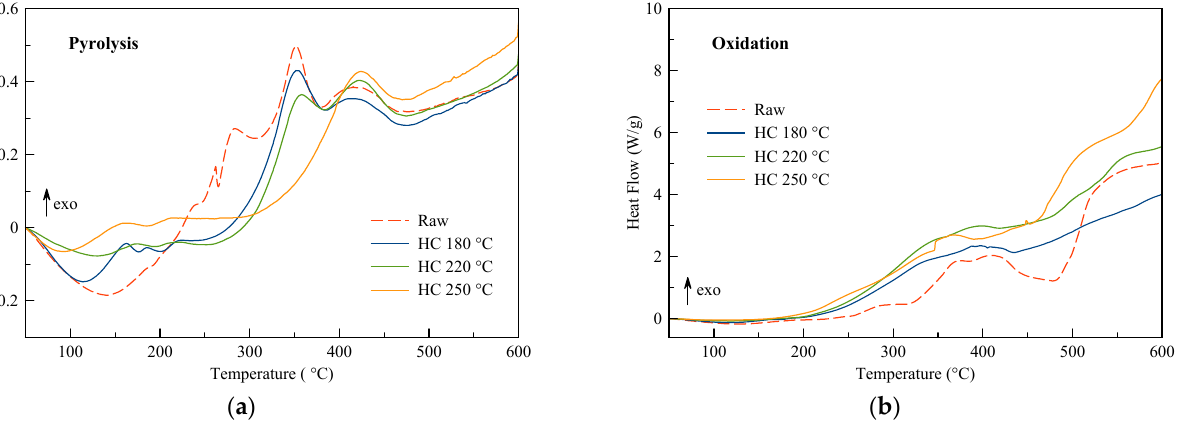
Figure 3. Differential scanning calorimetry (DSC) curves of grape seeds and hydrochars (HC) at 10 °C/min: ( a ) under inert and ( b ) oxidative atmosphere (> 0 exothermic, < 0 endothermic); per grams of dry feedstock. Table 4. Details of DSC curves: integrals, mass loss, and transition point from endothermic to exothermic behavior; per kilograms of dry feedstock. The positive values of “Net energy” correspond to exothermal behavior during thermal treatments.